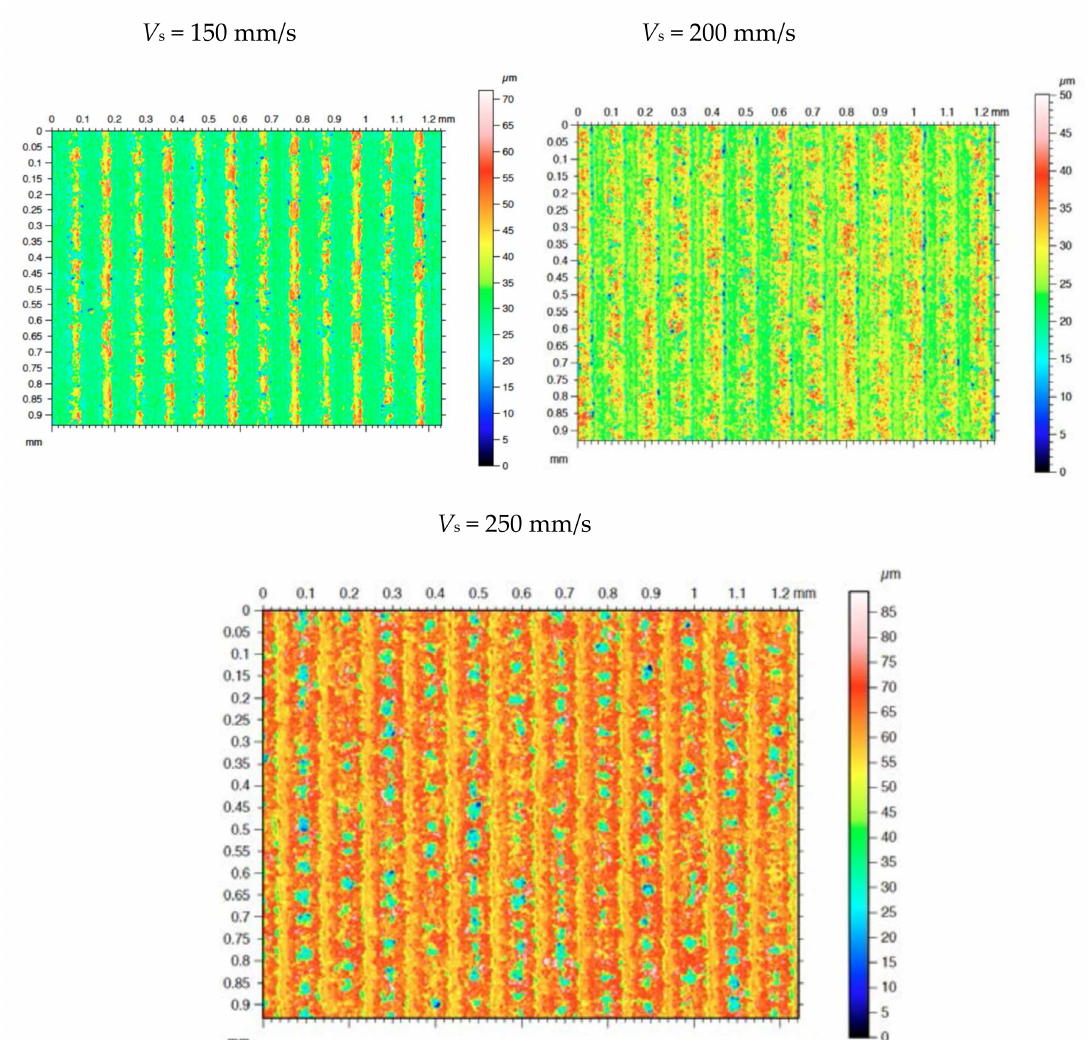
Figure 11. Topographic evolution of the textured layer for S -III speed set, which has the highest scanning speeds ( V s = 150 mm/s to V s = 200 mm/s, and V s = 250